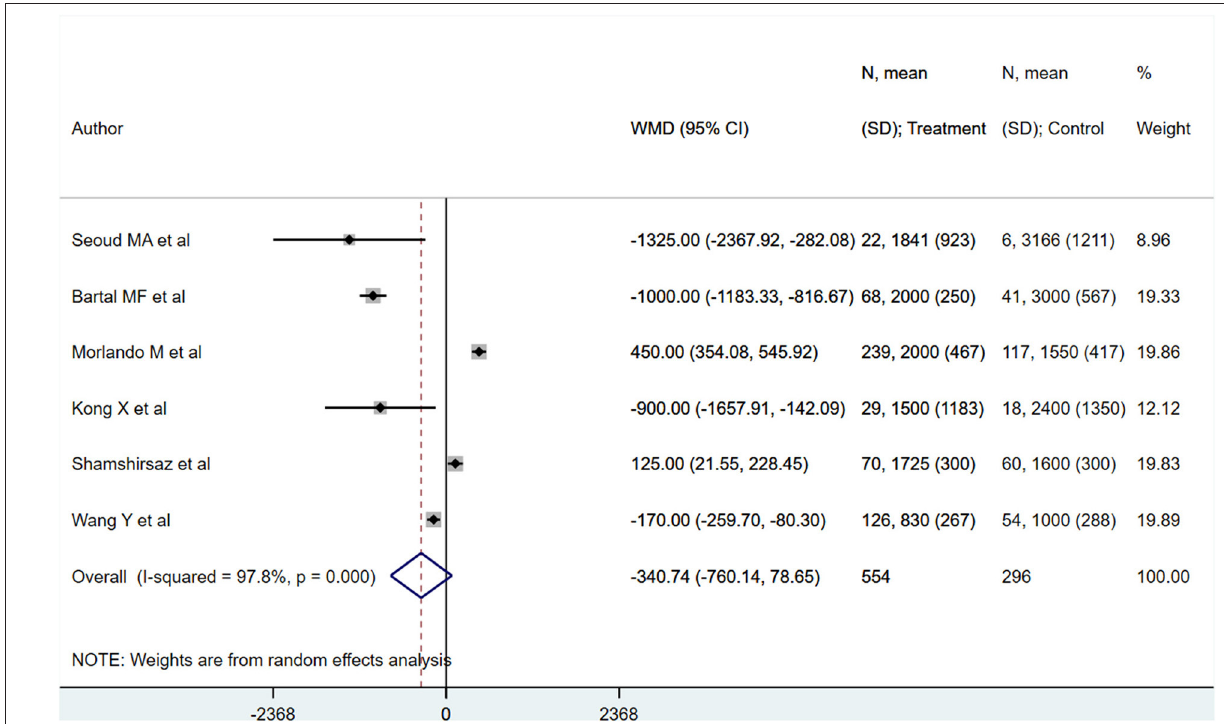
FIGURE 3 | Maternal blood loss for PAS patients undergoing planned or emergency delivery.